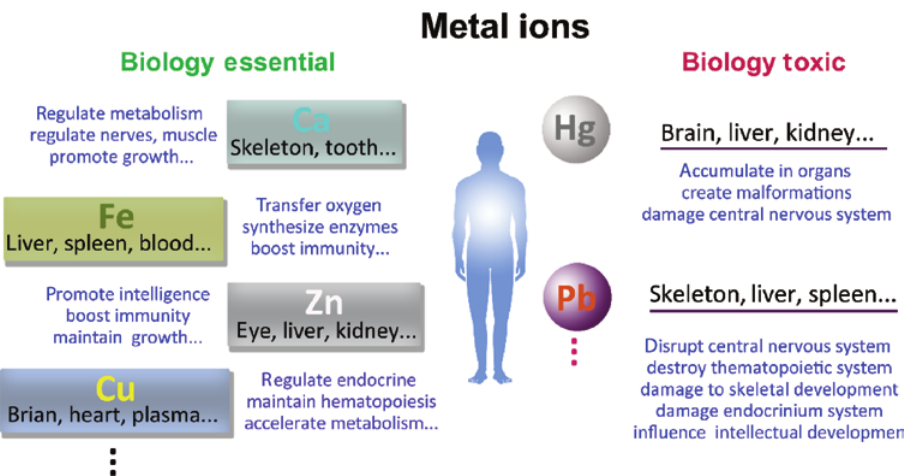
Figure 1: Effect of metal ions in the fundamental life